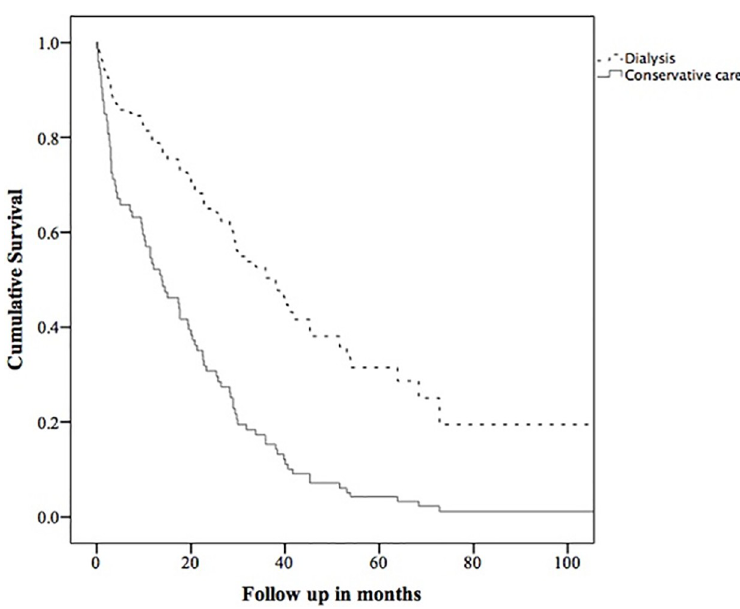
Fig 3. Survival curve comparing dialysis with conservative care from the date of first outpatient eGFR � 10 mL/ min/1.73m 2 . Adjusted for age and peripheral vascular disease.